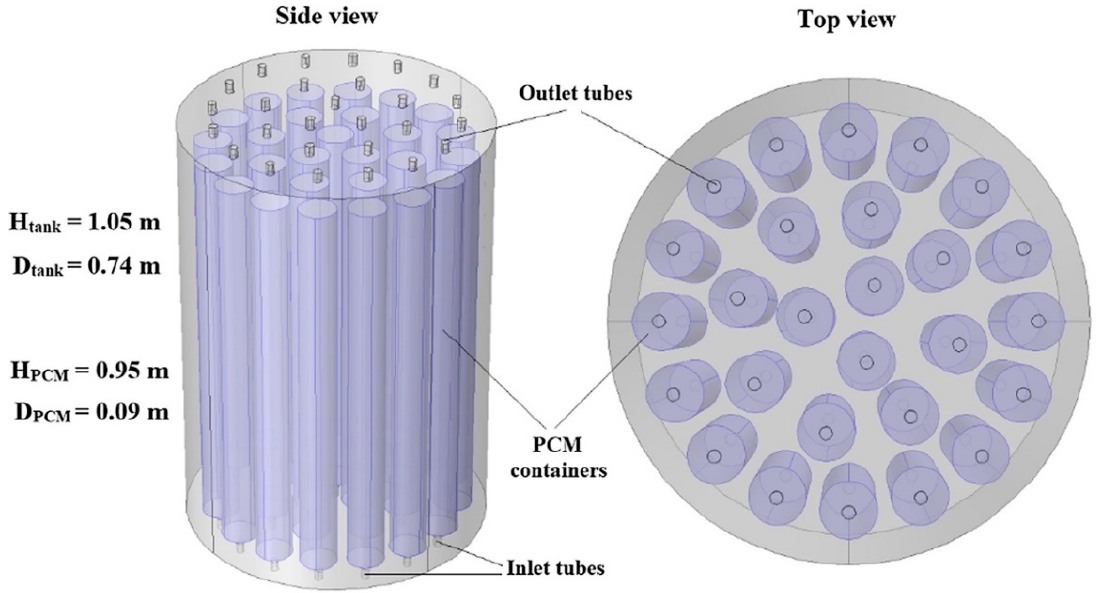
Figure 5. LHTES system configuration for the study by Akhmetov et al. (Copyright 2019 International Solar Energy Society) [31].